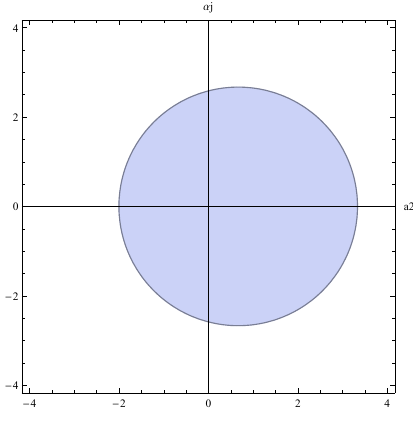
Figure 2 . Circle with no